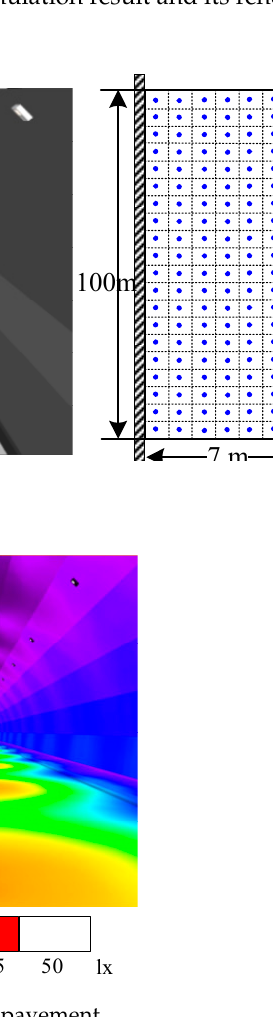
Figure 11. Simulation result and false-color image of road pavement.